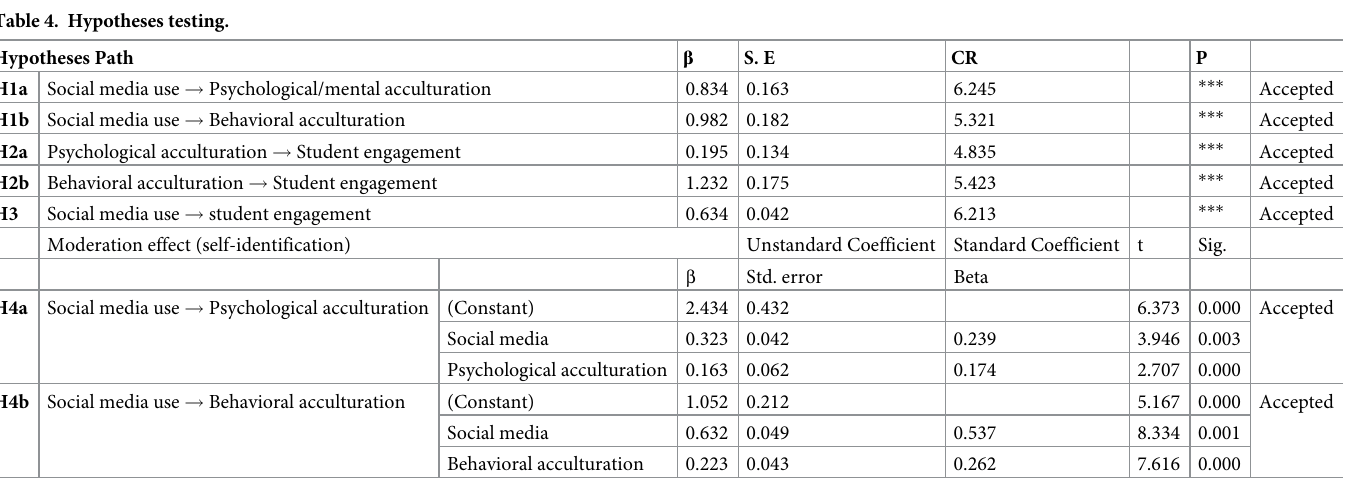
Table 4. Hypotheses